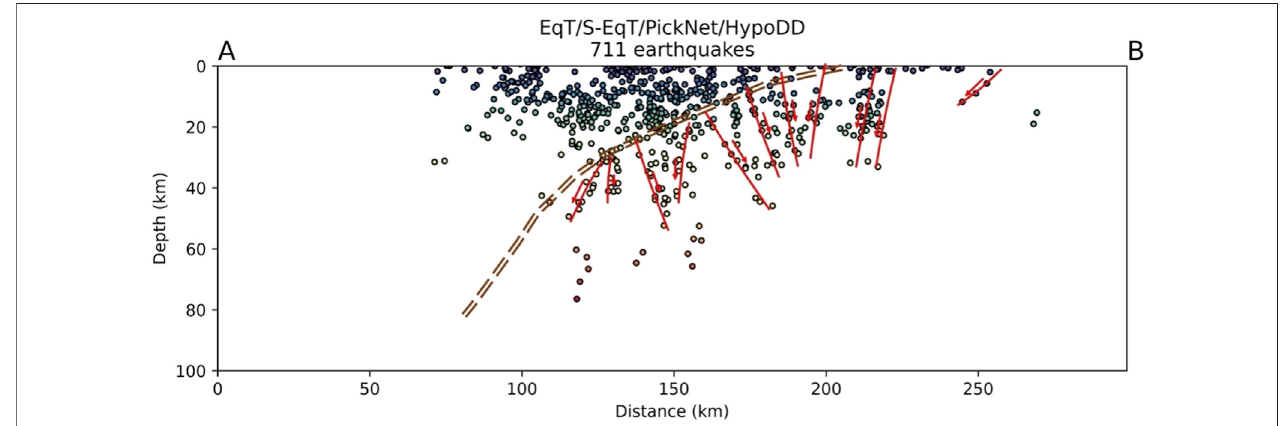
FIGURE 7 | Distribution of normal faults (red line and arrow) in the section. The slab geometry (brown dotted line) in the southern Mariana is based on SLAB2.0 model (Hayes et al., 2018).